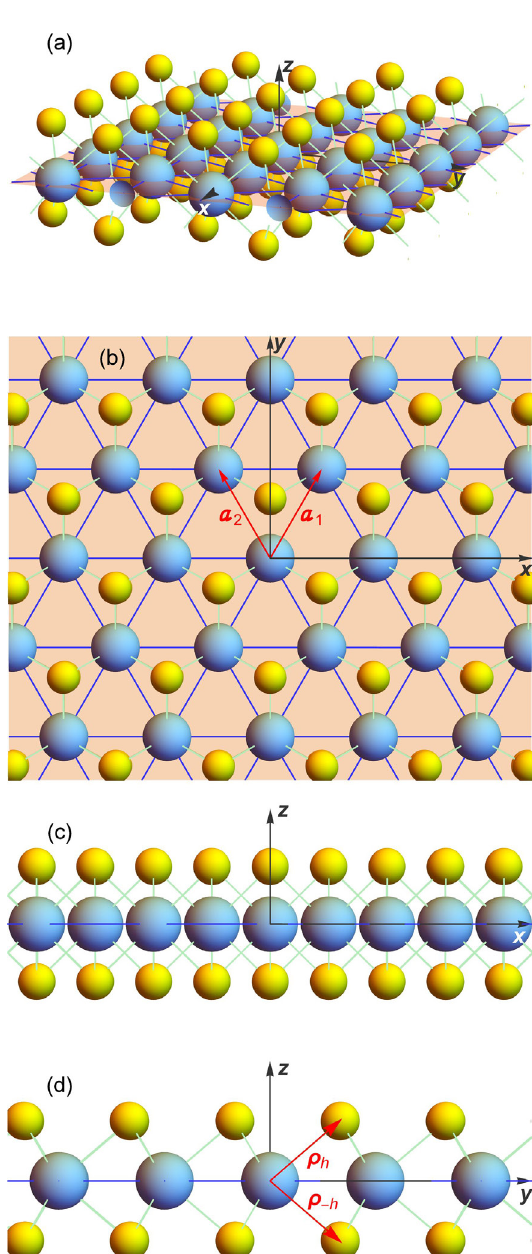
monolayer. The blue Figure 1. (a) 3D pictorial view of the MoS 2 (yellow) spheres are for the Mo (S) atoms. (b) Top view of panel (a), where the red arrows are for the vectors 1 a and 2 a . (c) Left view of panel (a). (d) Front view of panel (a), where the red arrow h − ρ